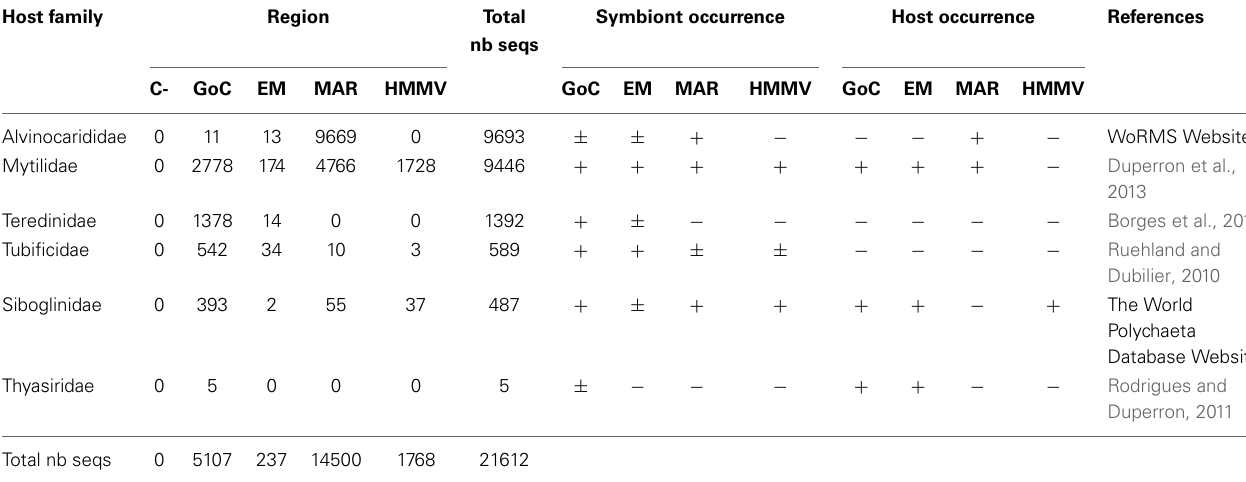
Table 3 | Symbionts and animal hosts occurrence in geographical regions analyzed in this study.